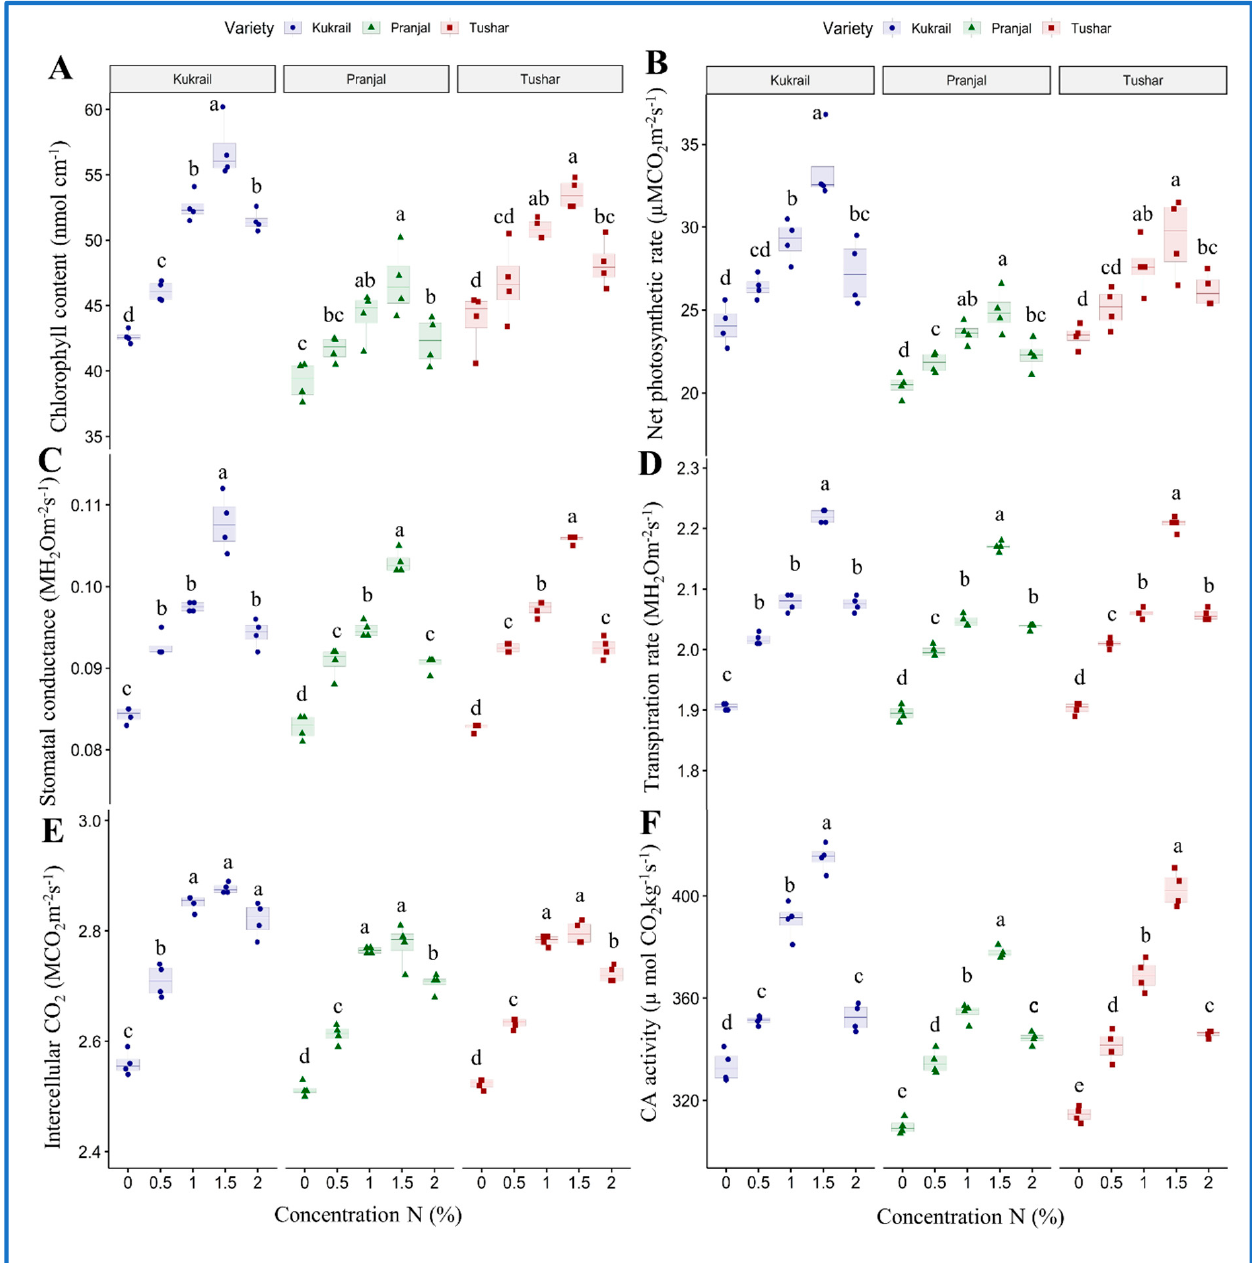
Figure 3. Effect of N on three cultivars: ( A ) Chlorophyll content, ( B ) Net photosynthetic rate, ( C ) Stomatal conductance, ( D ) Transpiration rate, ( E ) Intercellular CO 2 concentration, ( F ) CA activity of the three peppermint cultivars. The distinguished colored shapes in the box plot represent the individual reading of four replicates of each cultivar. The letters over the shapes represent the significance at p ≤ 0.05 by Duncan’s Multiple Range Test (DMRT).